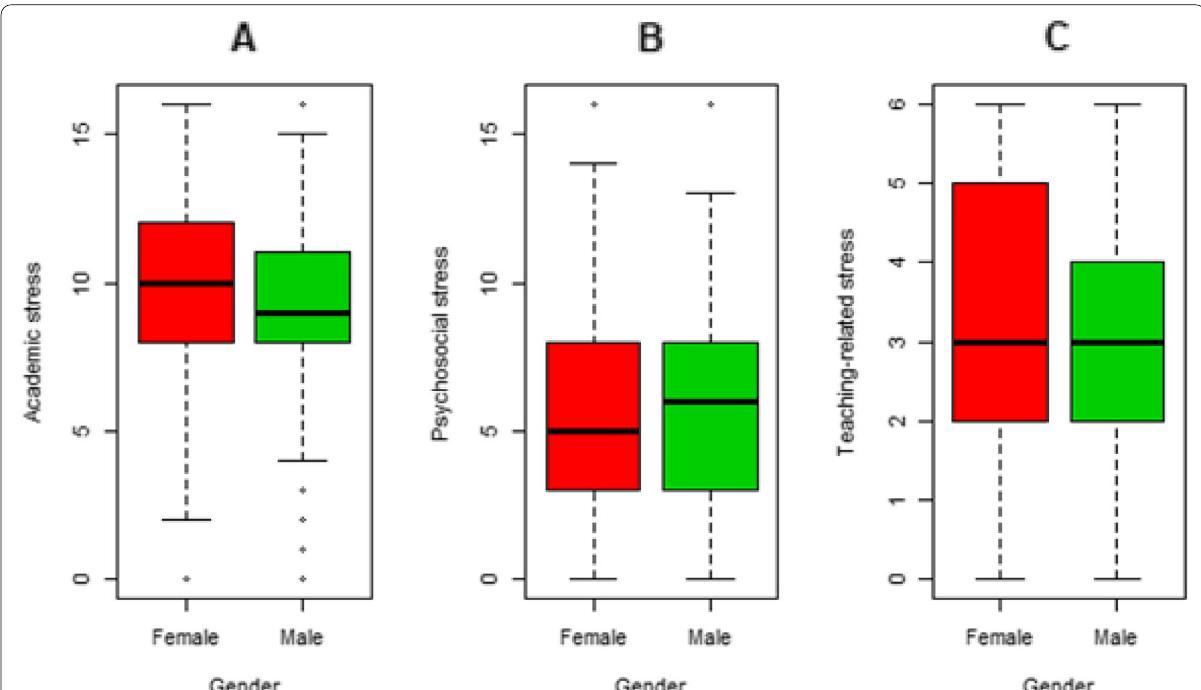
Fig. 1 Academic, psychosocial, and teaching-related stressors broken up by student gender. The box-and-whisker plots represent the stress scores ( A Academic, B Psychosocial, C Teaching-related) broken-up by student gender. Note that the borders of the box represent the interquartile range and the whisker terminals represent the maximum and minimum score. The median score is represented by the thick black line in the middle of the box. Female students were more academically stressed than